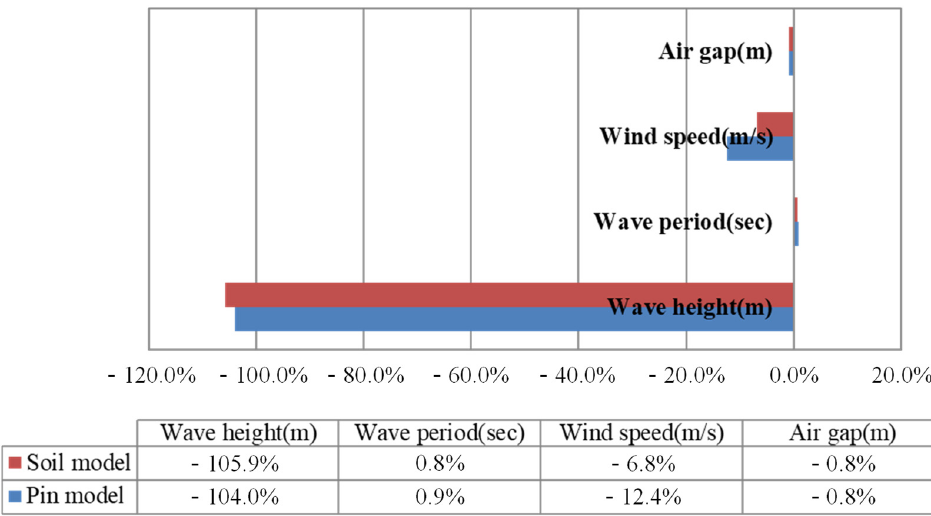
Figure 13. Summary of effect of structural response according to parameters .